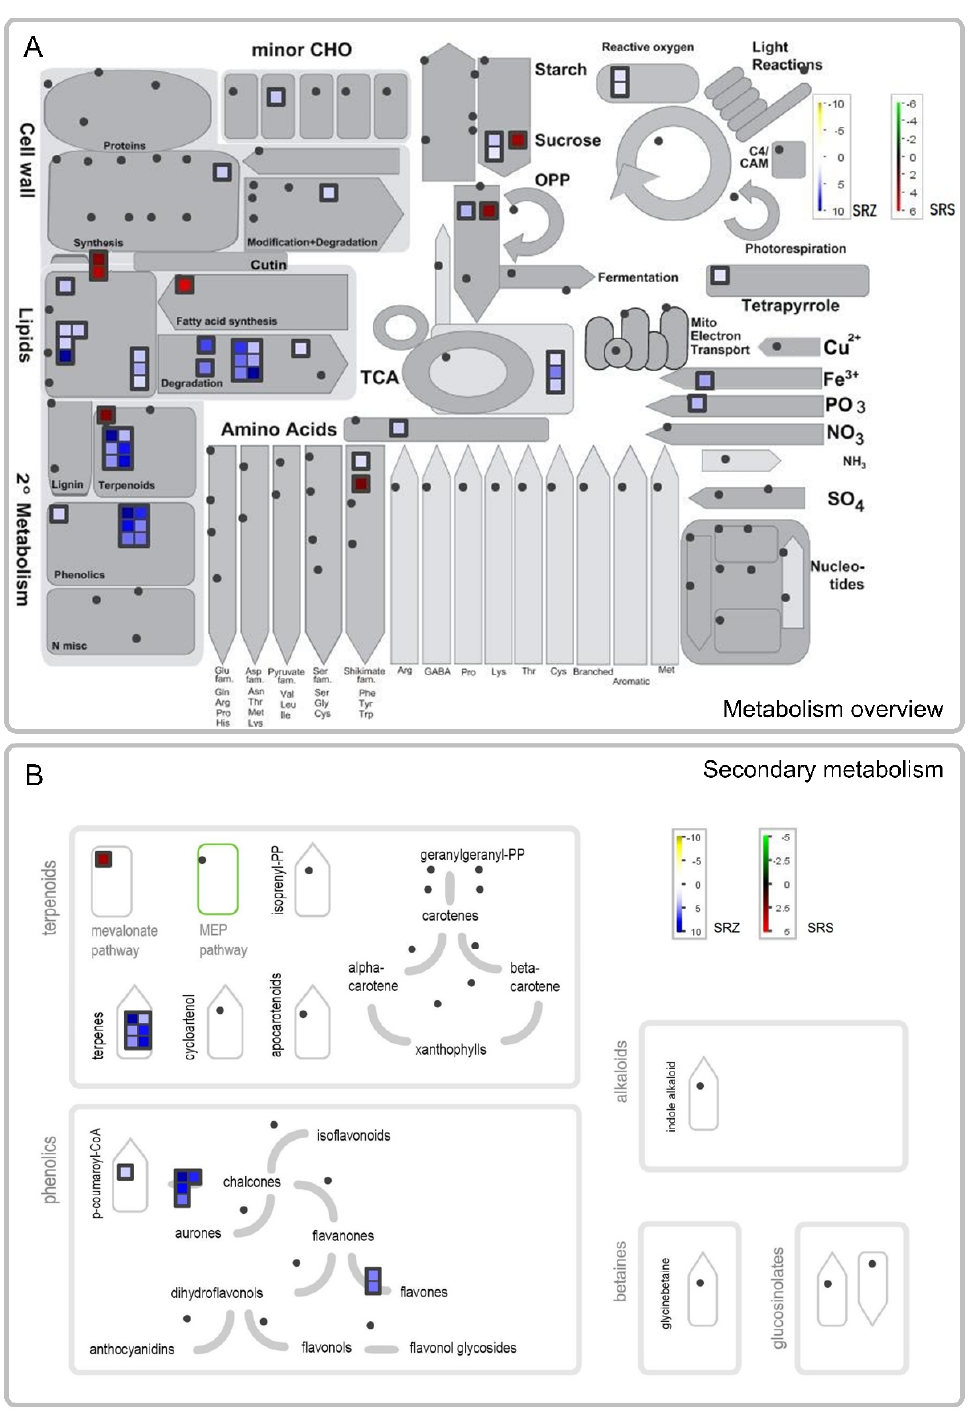
Figure 6. MapMan visualization of differentially expressed genes of Sorghum bicolor at 3 days after inoculation with S. reilianum f. sp. reilianum (SRS) or S. reilianum f. sp. zeae (SRZ). An overview of the metabolism is shown in ( A ), while ( B ) focuses on the genes involved in secondary metabolism. Significantly regulated genes are represented by squares whose color indicates the degree of regu- lation. In the comparison of Sb-SRS vs. Sb-H 2 O, the green–black–red color gradient indicates downregulated–not-regulated–upregulated genes, while in the comparison of Sb-SRZ vs. Sb-H 2 O, the used color gradient is yellow–white–blue. Dots indicate that the respective genes were not among the detected significantly regulated